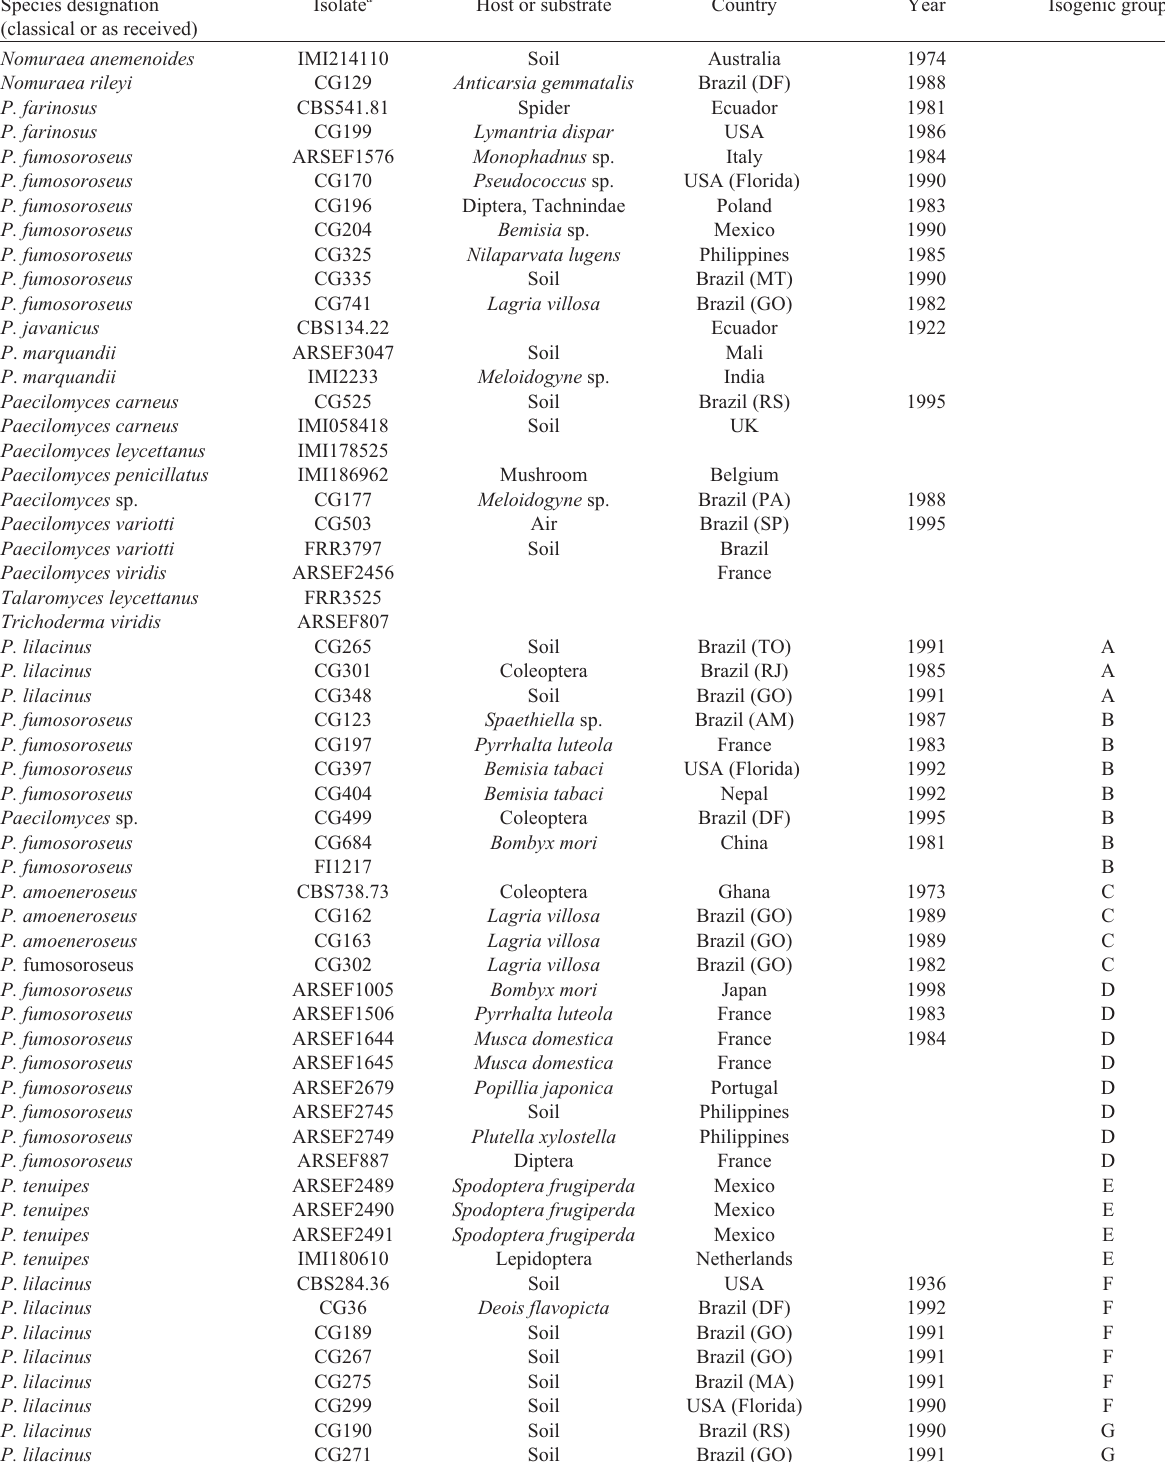
Table 1 - Origin and conventional classification of isolates, whose ITS1-5.8S-ITS2 DNA was sequenced in this